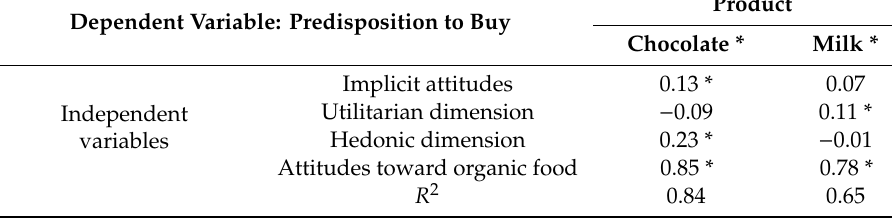
Table 7. Standardized